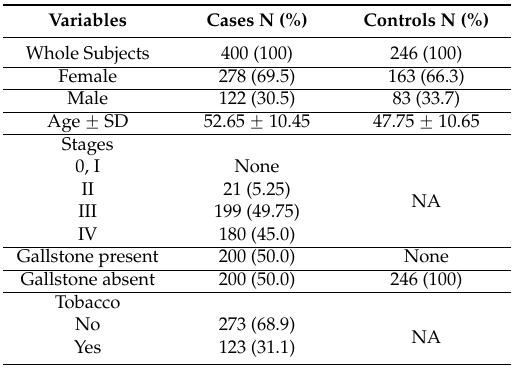
Table 1. Characteristic of the Study